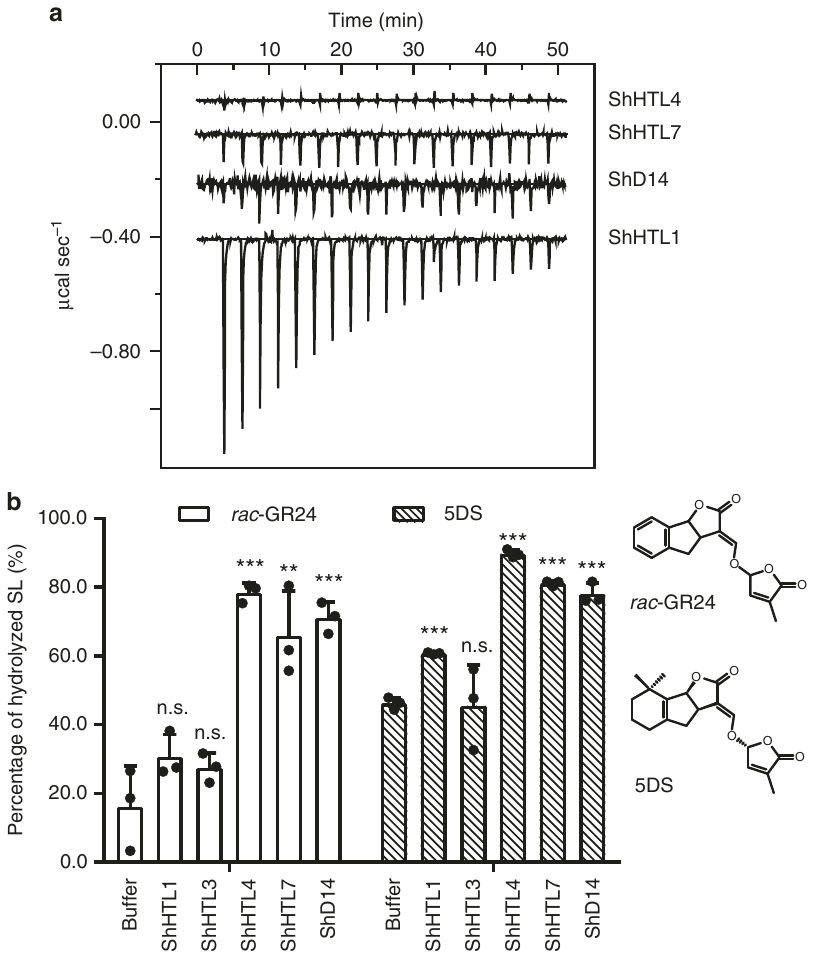
Fig. 1 In vitro ligand speci fi city of ShHTLs and ShD14. a ITC thermograms titrating KAR 1 into ShHTL1, ShHTL4, ShHTL7, and ShD14, respectively. K D of KAR 1 to ShHTL1 was 77 ± 12 μ M, calculating from three independent experiments (means ± standard deviation (SD), n = 3). b Hydrolysis of rac -GR24 and 5DS by ShHTLs. rac -GR24 or 5DS was incubated with or without puri fi ed enzymes (ShHTL1, ShHTL3, ShHTL4, ShHTL7, and ShD14) for 30 min at 30 °C. HPLC analysis was used to detect the remaining amount of rac -GR24 and 5DS. Columns represent the mean value and error bars the SD of three replicates (means ± SD, n = 3). Each replicate is indicated by a black dot. The asterisks indicate statistical signi fi cance from the buffer (non-enzyme sample) as *** p ≤ 0.001; ** p ≤ 0.01 and n.s., p > 0.05, as measured by the one-tailed unpaired t -